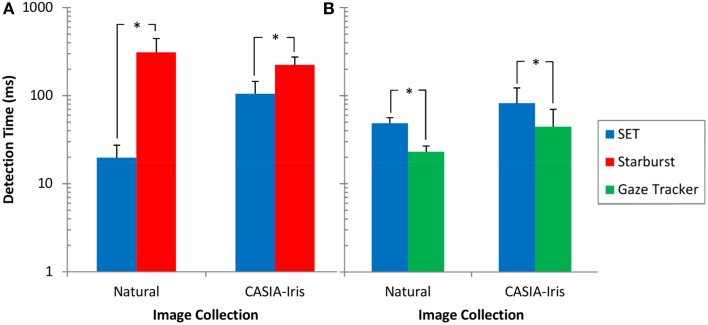
Detection time for different methods and image collections. (A) Comparison between SET and Starburst. For this comparison both SET and Starburst algorithms are run in MATLAB. (B) Comparison between SET and Gaze-Tracker. For this comparison both SET and Gaze-Tracker are run in C#. Error bars reflect one standard deviation. *p < 0.001.